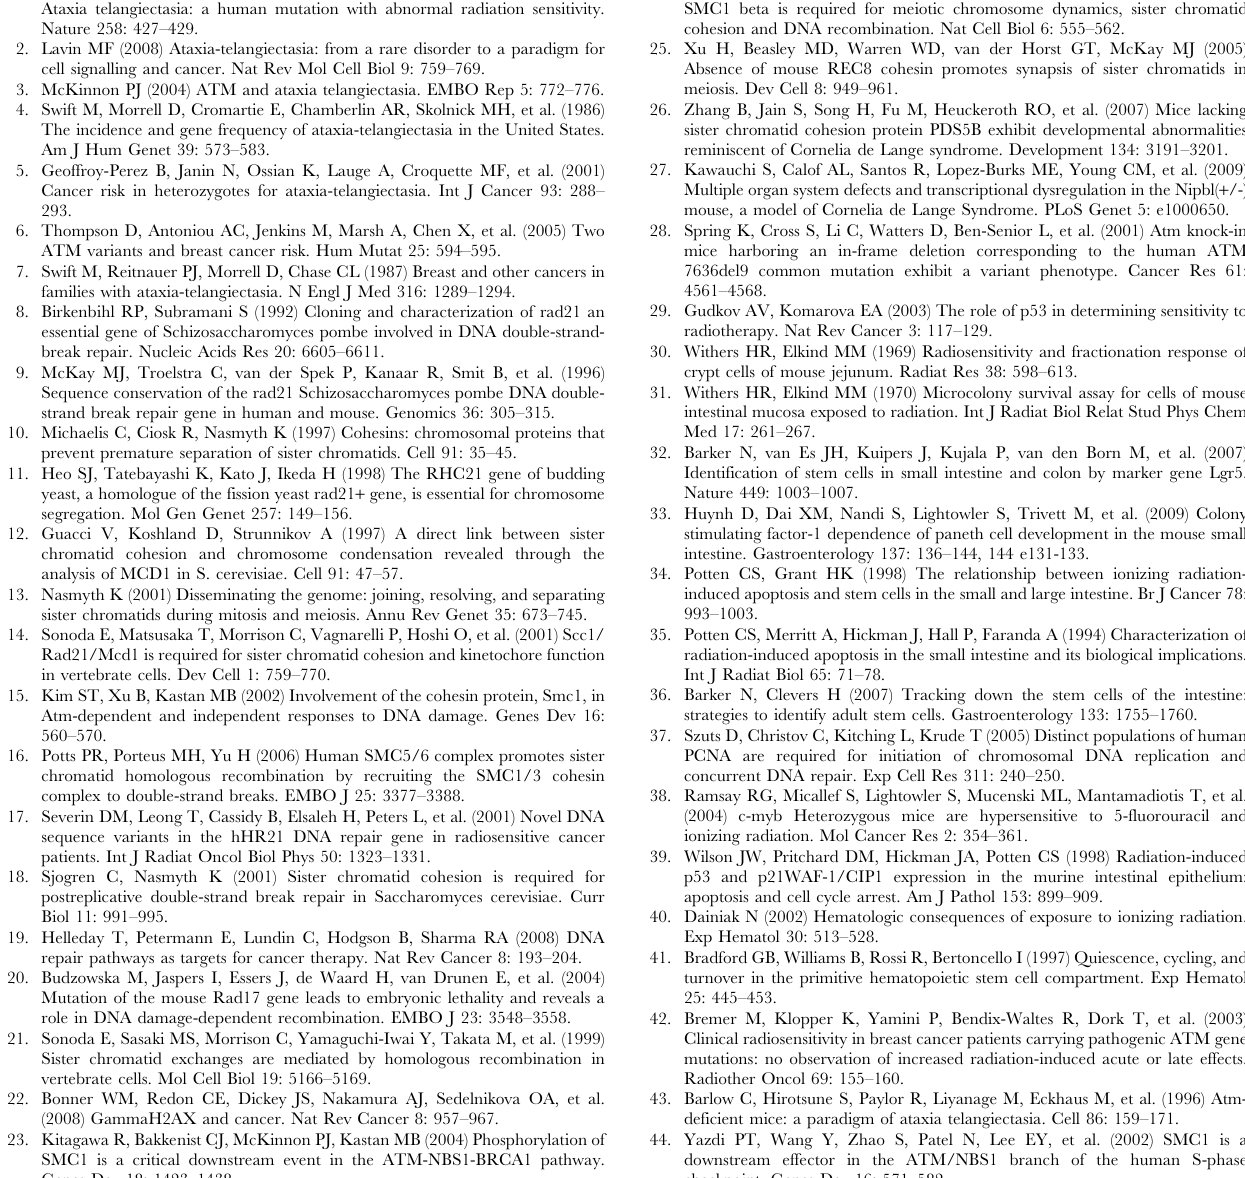
Found at: doi:10.1371/journal.pone.0012112.s006 (0.10